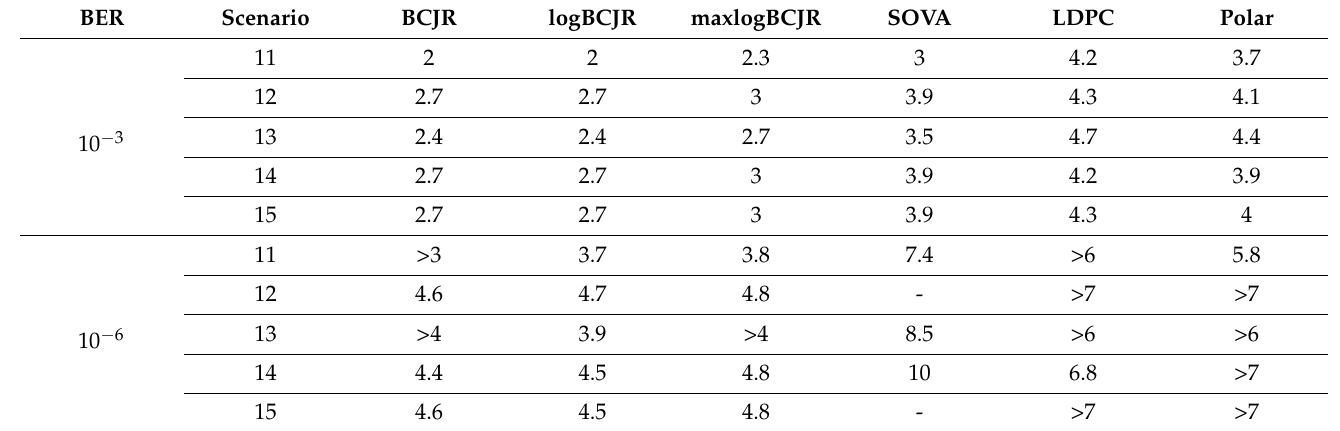
Table 11. SNR in dBs for BER values of 10 − 3 and 10 − 6 , 512-bit frame.